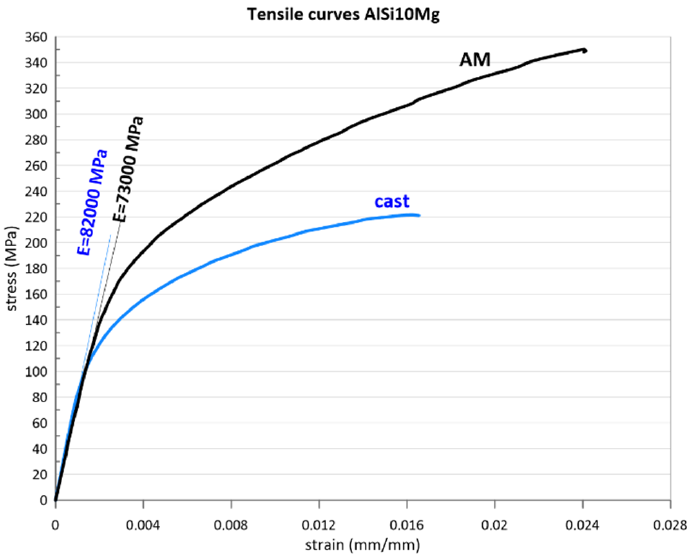
Figure 3. Resulting tensile test diagrams of AlSi 10 Mg material.